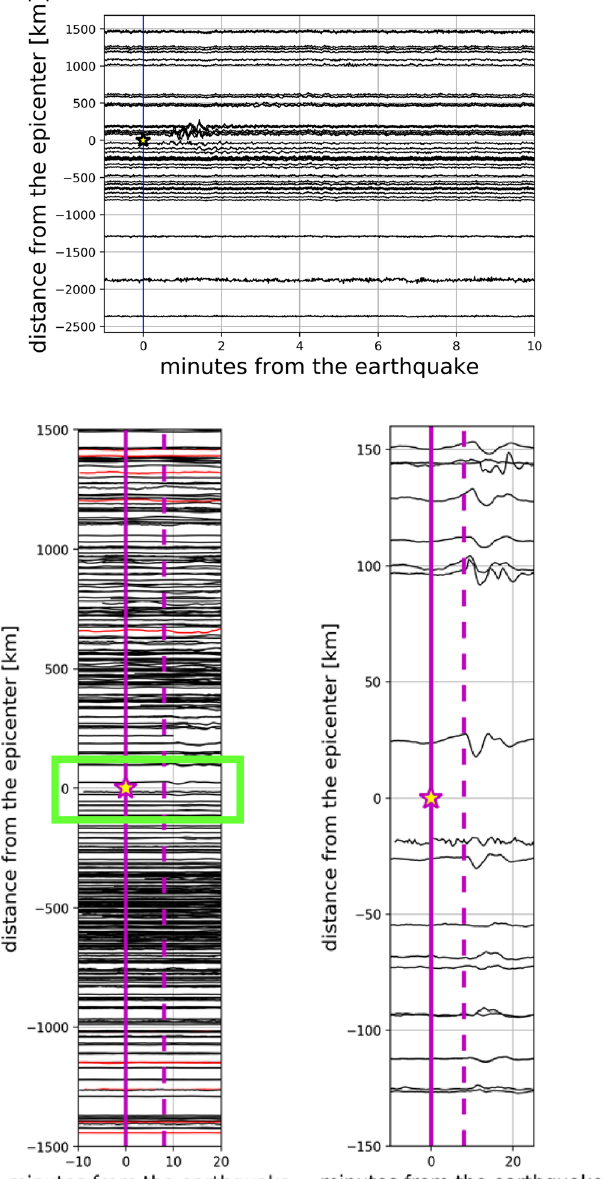
Figure 2. Upper panel—Real-time scenario estimated ground motion (Up component) through VADASE. Bottom panels—sTEC variations for all the satellites in view for all the GPS stations computed through VARION in range of 1500 km from the epicenter (left panel) and a zoom in the range of 150 km (right panel). In both cases, positive and negative distances represent respectively the IPP position at 8 min after the earthquake placed north and south the